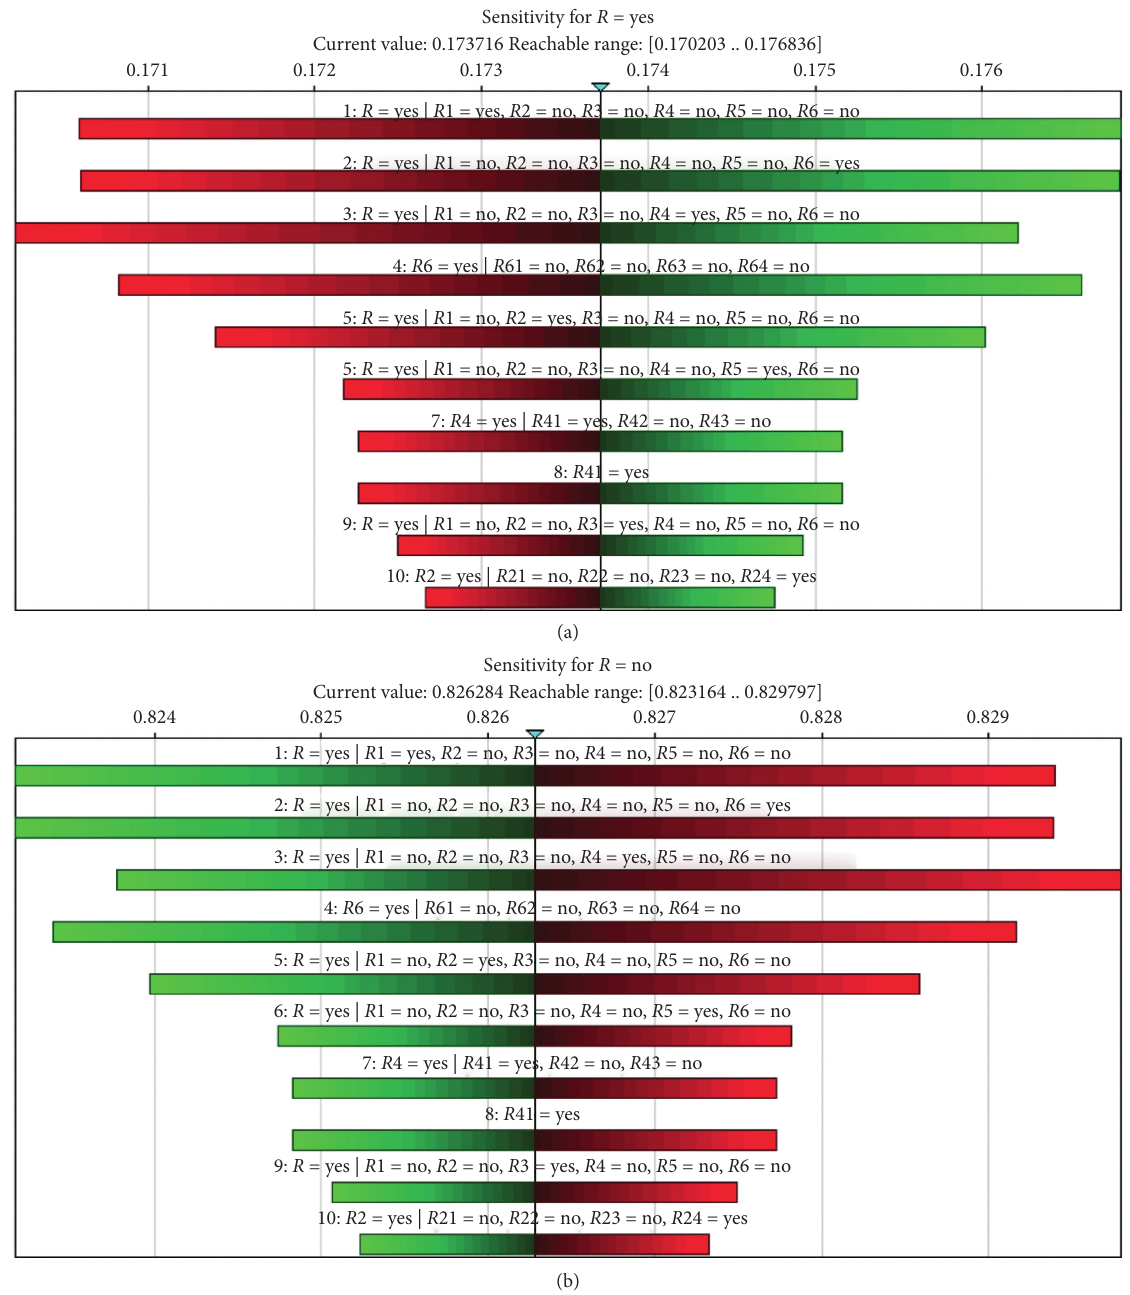
Figure 5: Sensitivity analysis of the project portfolio resource risk. (a) PPRR � “yes” state. (b) PPRR � “no”